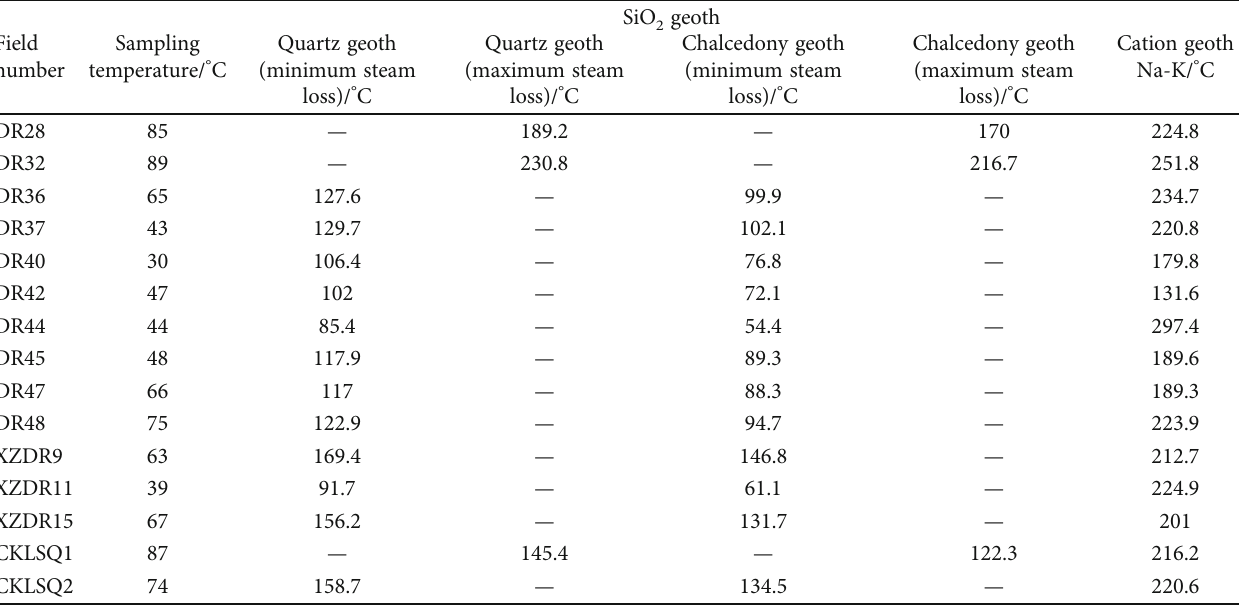
Table 7: Estimated results of the reservoir temperature in the study